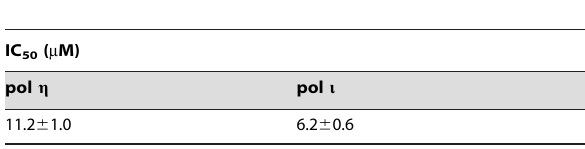
Table 1. Summary of IC 50 s of candesartan cilexetil for the inhibition of pol g and pol i in replicating non-damaged DNAs.